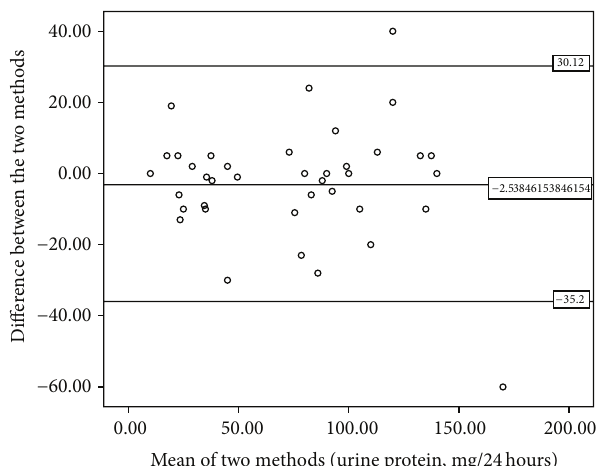
Figure6:Bland-Altmanplot:Relationbetweenthenewmethodand the conventional 24-hour urine protein. The horizontal lines show the limits of agreement of the differences between the two